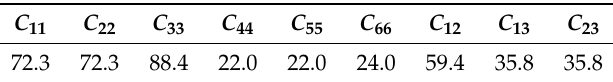
Table 2. Elastic constants (GPa) for tin